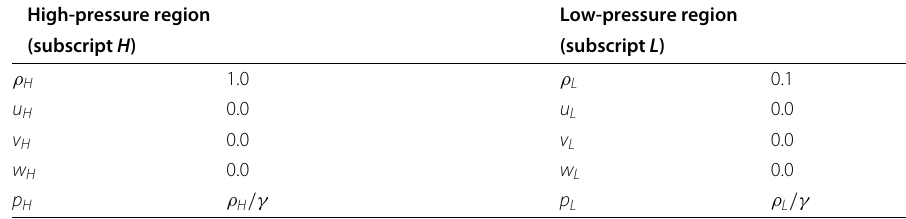
Table 1 Initial conditions (shock tube test) High-pressure region